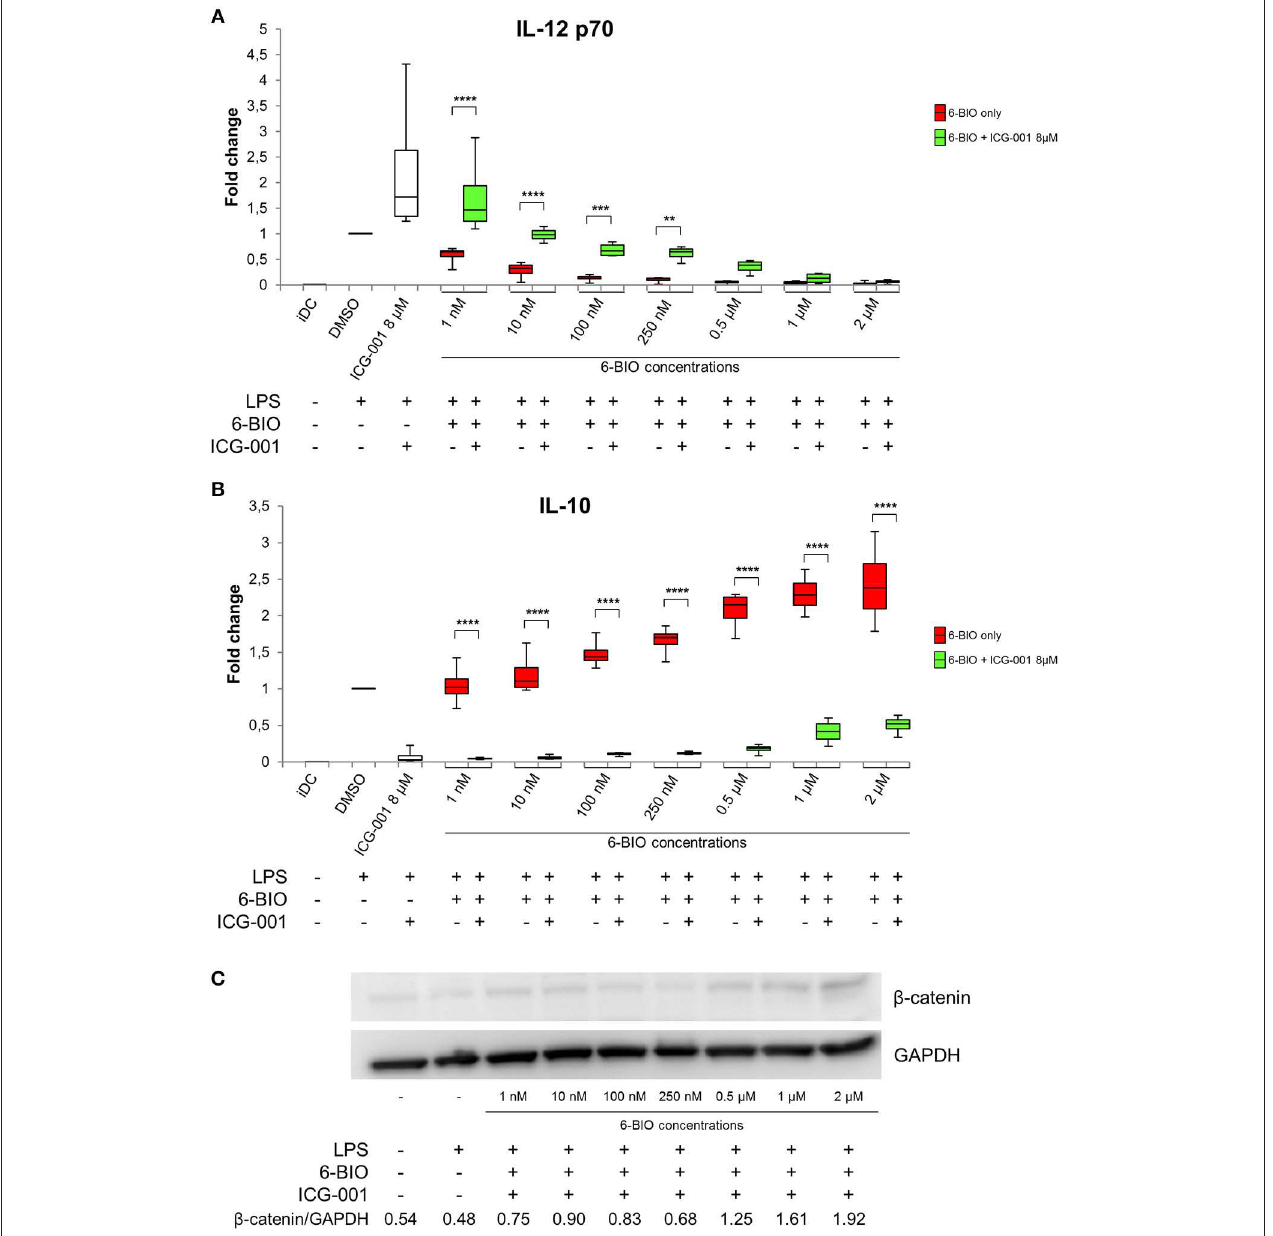
FIGURE 3 | moDCs obtained from healthy donors were treated with 8 µ M ICG-001 and/or indicated concentrations of 6-BIO or DMSO (vehicle) for 24h with 30ng/ml of LPS for the last 23h or left untreated as iDC. (A,B) Each vertical box and whisker plot shows the fold change compared to untreated DMSO controls of IL-12p70 and IL-10, respectively, measured by ELISA. The lines represent the median, edges of the box represent 25th and 75th percentiles, and whiskers display the smallest and highest value, n = 5. (C) β -catenin protein levels were measured by Western blot in whole-cell lysates. * p ≤ 0.05, ** p ≤ 0.01, *** p ≤ 0.001, **** p ≤ 0.0001 using two-way ANOVA with Tukey’s multiple comparisons test and 95% confidence